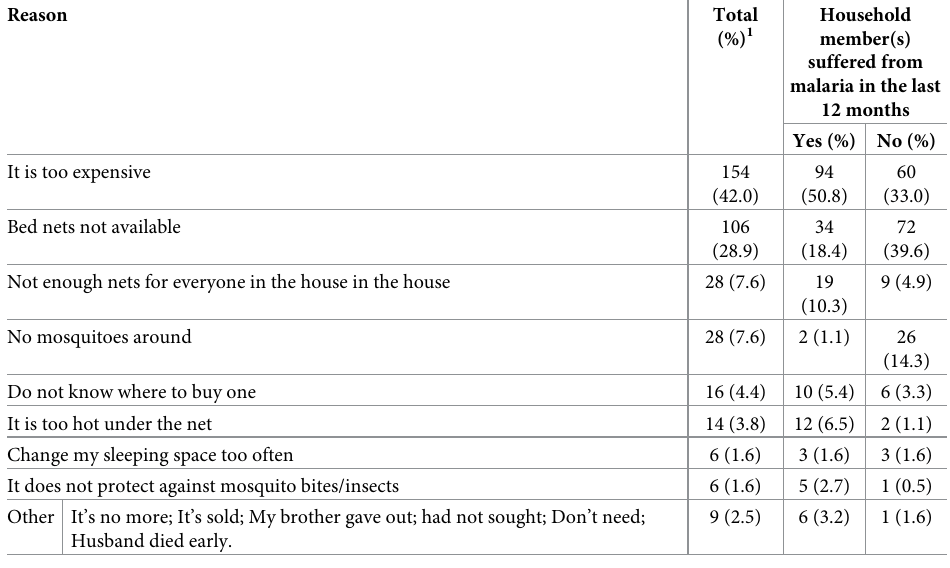
Table 4. Reported reasons for the households not owning an LLIN, Mogadishu–Somalia,